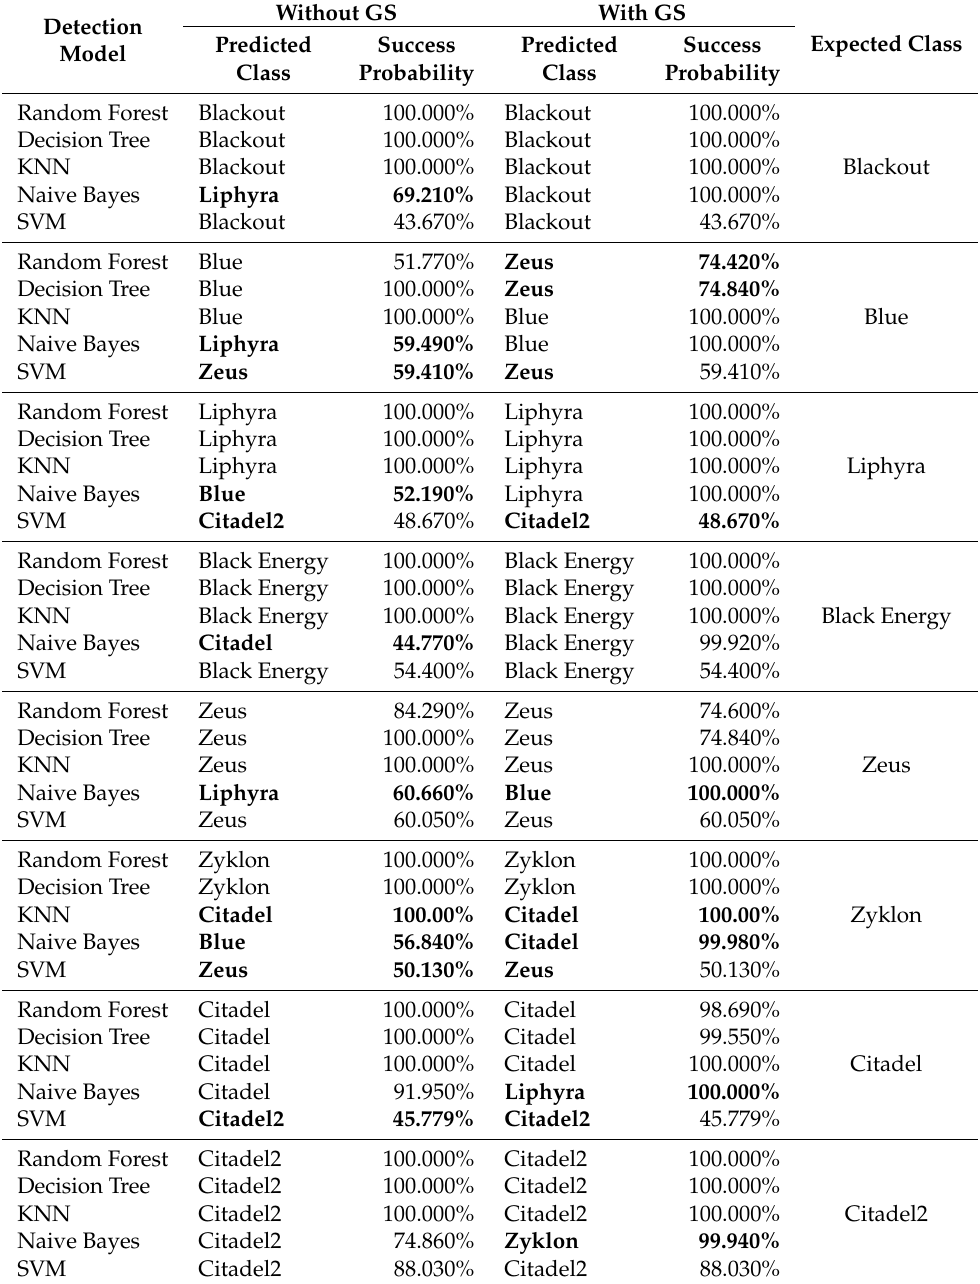
Table 11. Prediction results using ISOT HTTP Botnet